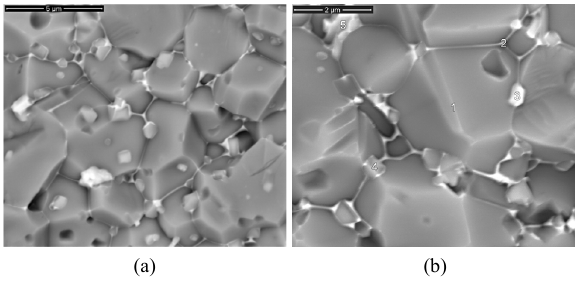
Fig. 4 SEM images of fractured cross-section of a multilayer varistor sintered at 1050 ℃ : (a) 20000×, (b) 40000×. In the points 1–5, EDS analysis was performed.